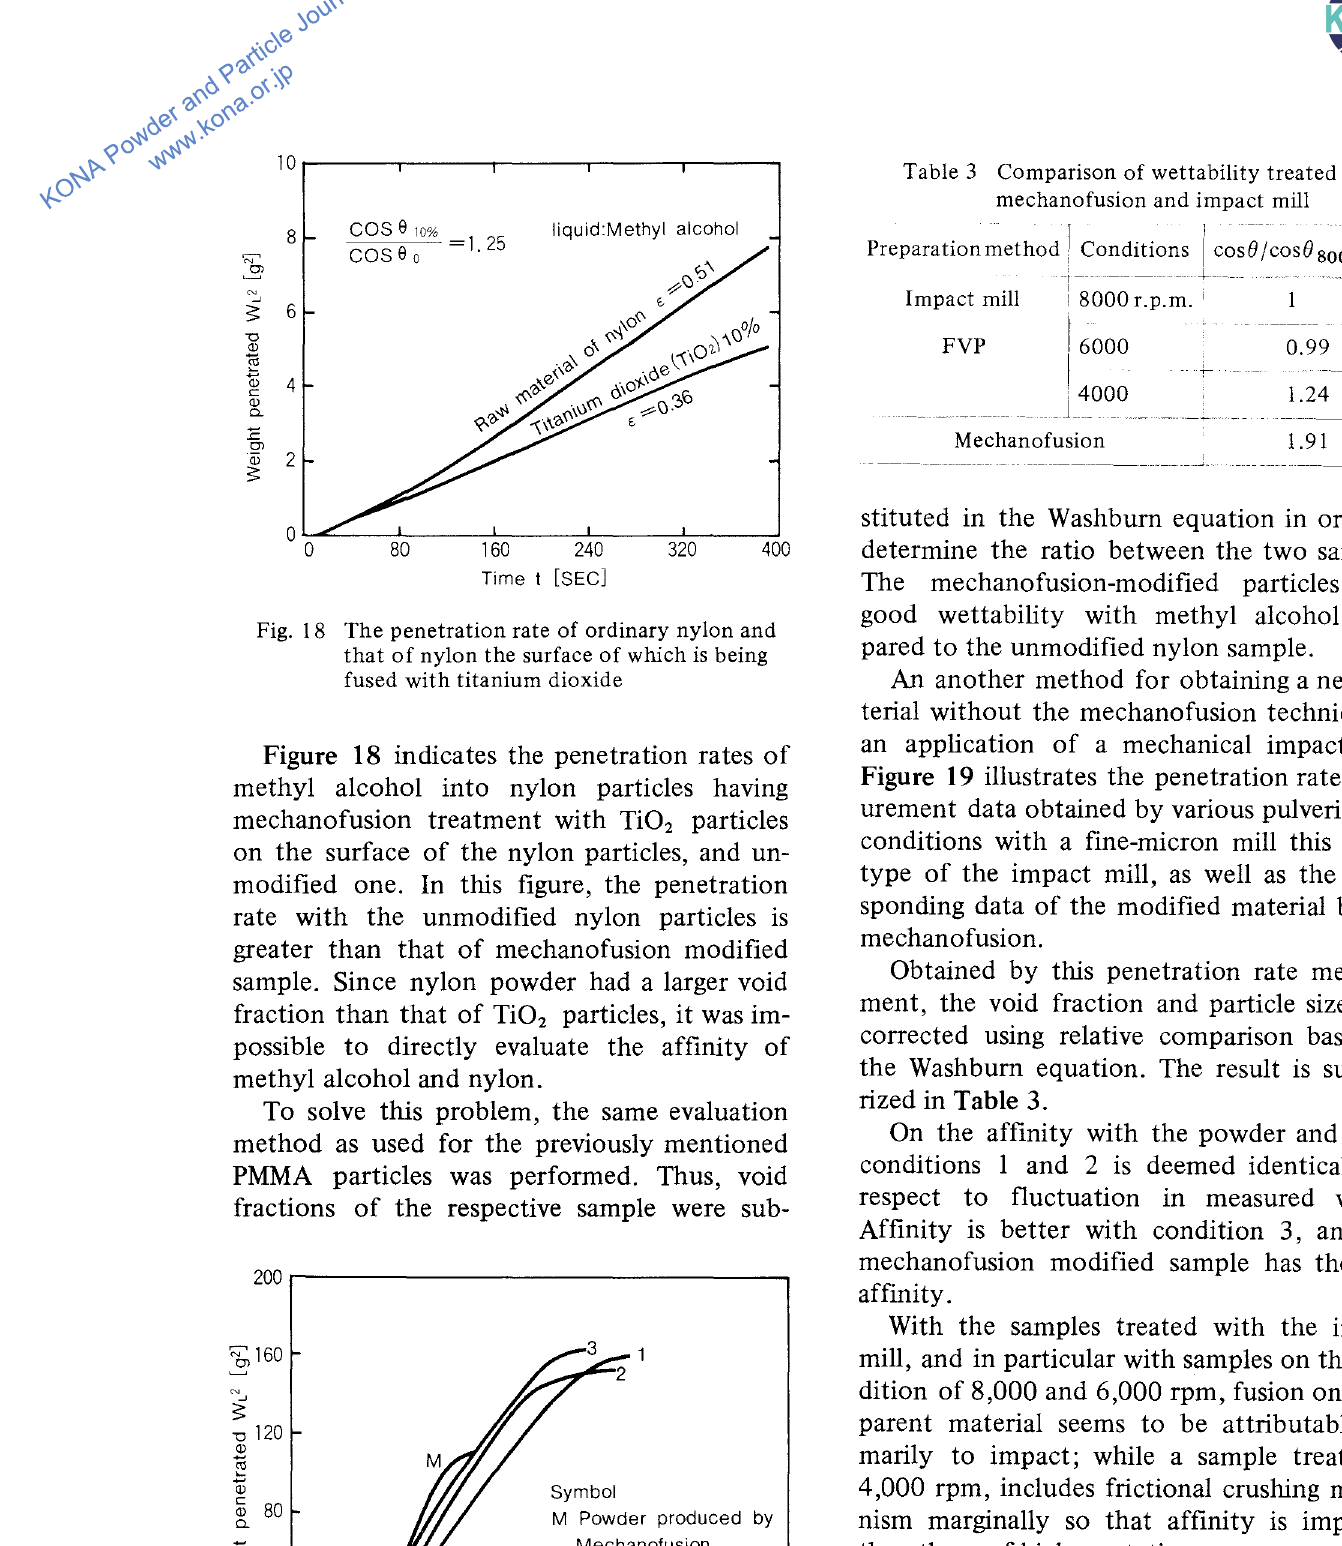
Fig. 19 Penetration ratios of PMMAs the surface of which is fused respectively with different methods